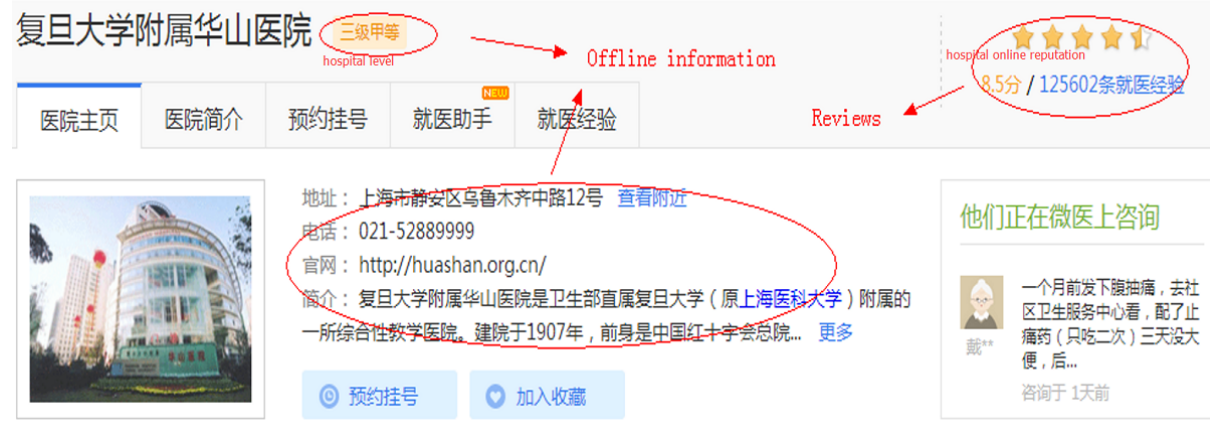
Figure 3. A hospital’s home page on the WeDoctor